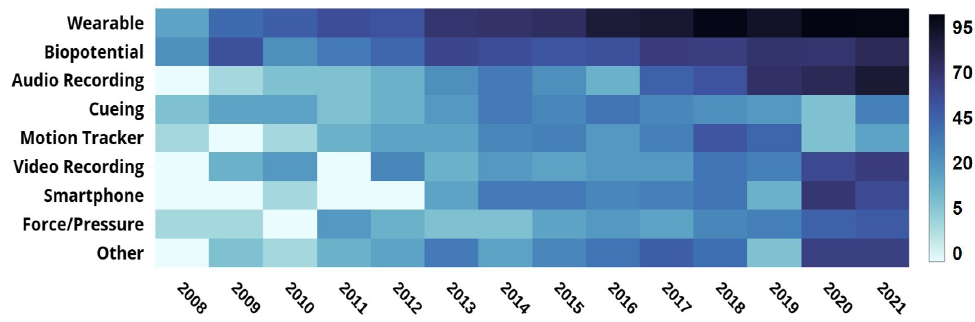
Figure 12. The heat-map presenting the number of research publications (2008–2021) that address PD assessment using modern technology (the darker the color, the higher the number.